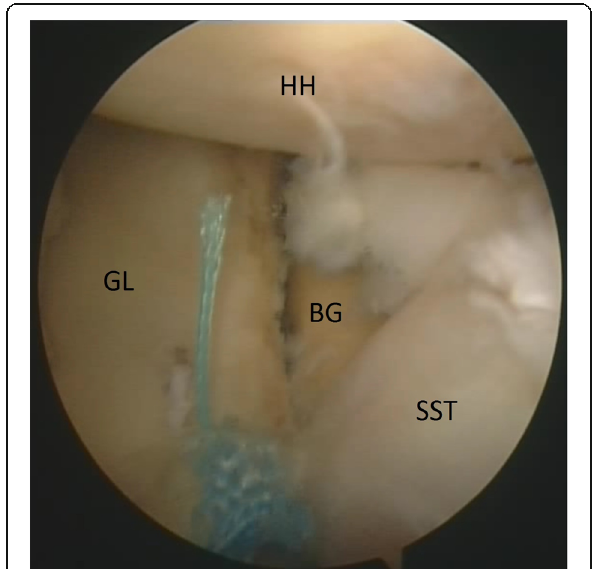
Fig. 9 Left shoulder. Final view from the antero-superior portal showing the closure of the anterior pounce on the bone graft and subscapularis tenodesis (HH: humeral head, GL: glenoid, BG: bone graft, SST: subscapularis tendon)